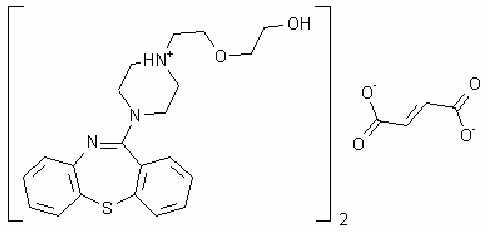
Figure 1 . Chemical structure of quetiapine